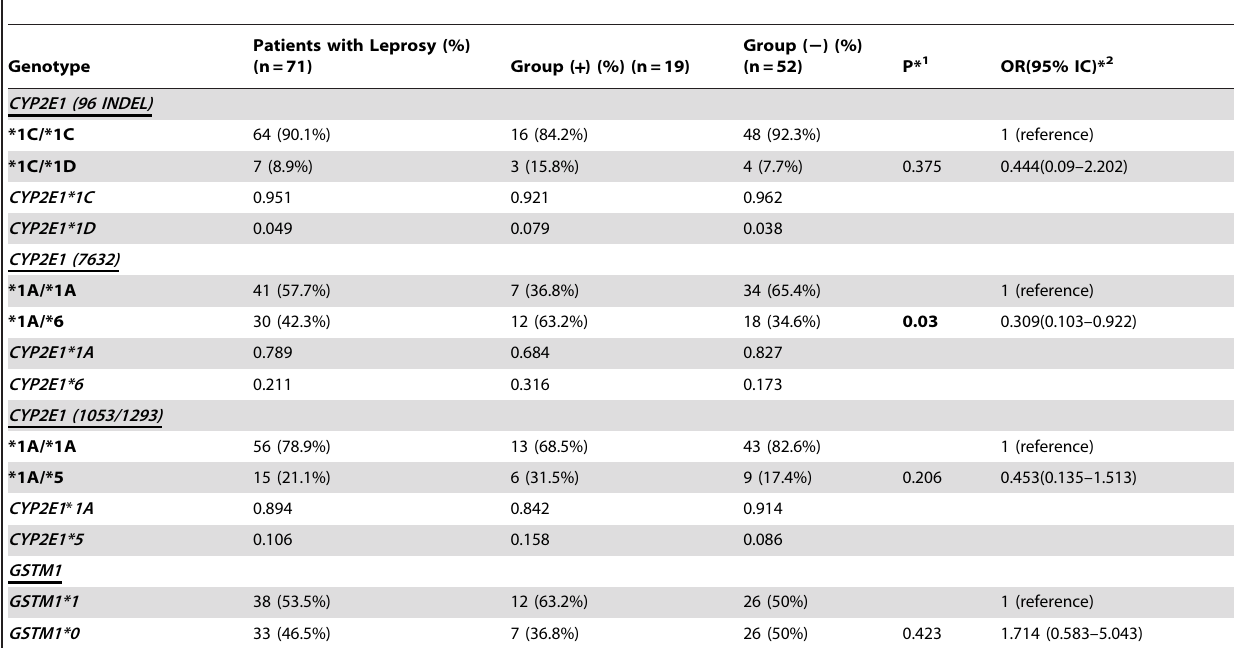
Table 2. Genotypic and allelic distribution of SNPs on CYP2E1 and GSTM1 genes among patients grouped according to clinical